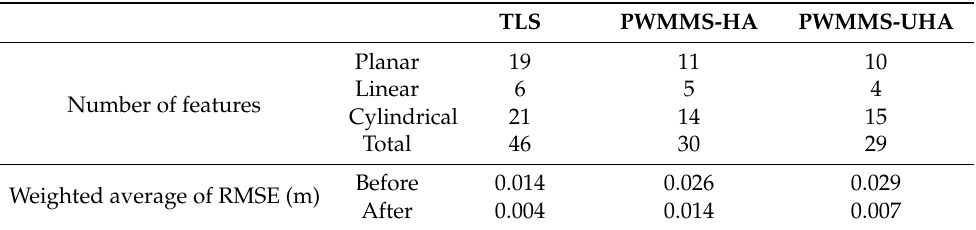
Table 2. Weighted average of the RMSE of plane/line/cylinder fittings before and after registration for TLS, PWMMS-HA, and PWMMS-UHA.